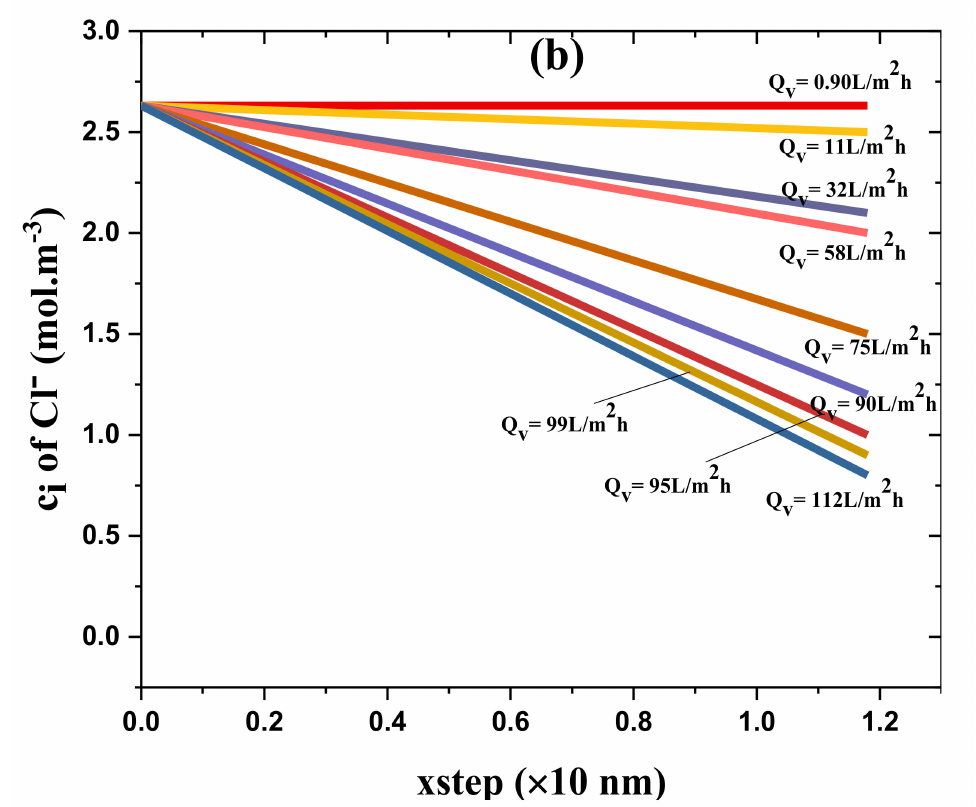
Figure 7. ( a ) Mg 2 + ion concentration in the organic-inorganic NF_PAN_Ti active layer as a function of the step size (for various solutions flux ( Q v )); ( b ) Cl − ion concentration in the organic-inorganic NF_PAN_Ti active layer as a function of the step size (for various solutions flux ( Q v )).